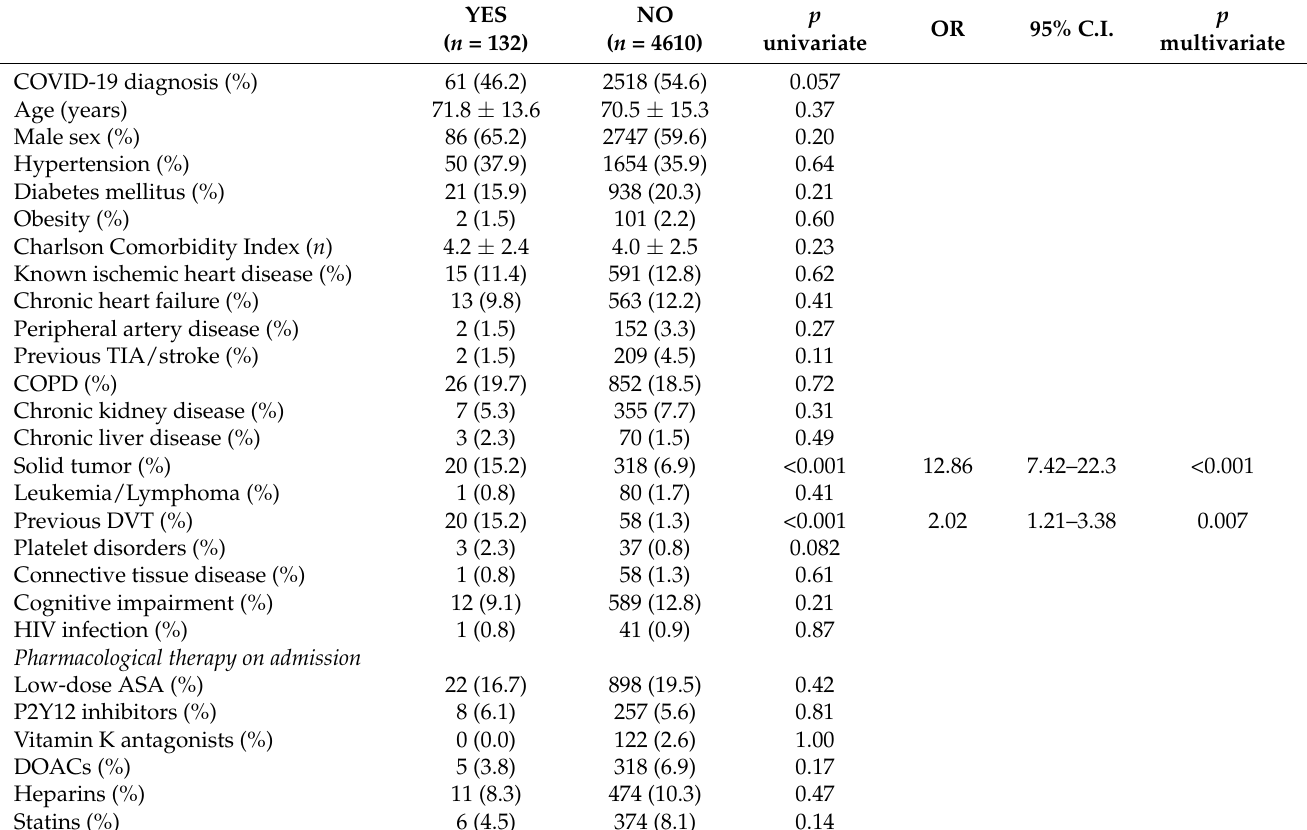
Table 6. Cumulative venous thrombosis in the whole population.